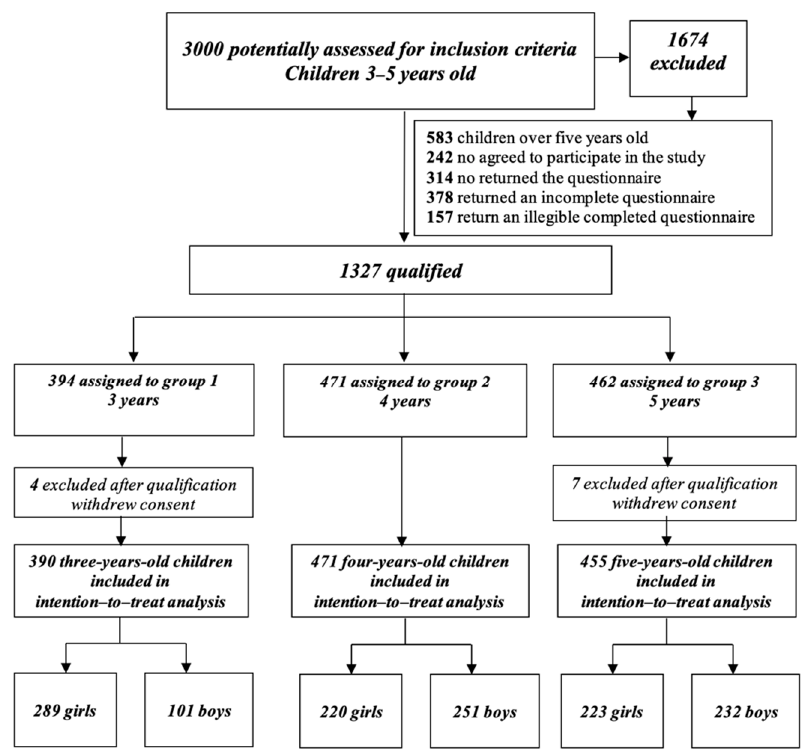
Figure 1. Flow diagram for selection and inclusion criteria.